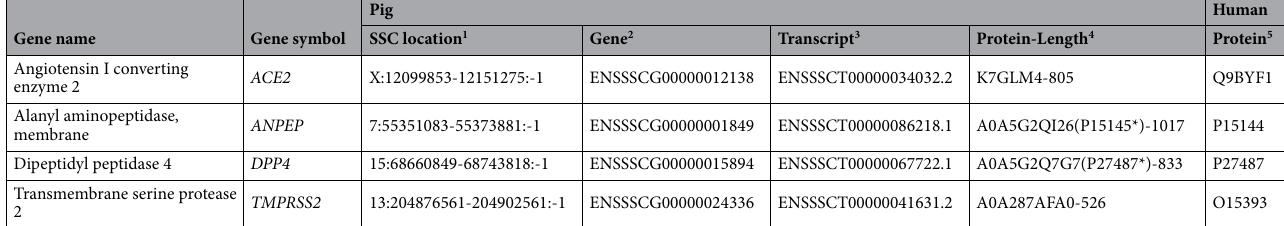
Table 1. Candidate genes investigated in the present study. 1 Porcine chromosome, starting position, ending position, gene orientation. Coordinates are based on the Sscrofa11.1 reference genome; 2 Ensembl gene identifier; 3 Ensembl canonical transcript identifier (it is defined as the longest CCDS translation with no stop codons); 4 UniProtKB accession number related to the Ensembl canonical transcript. The number of residues of the protein is reported; 5 UniProtKB accession number. *Alternative reviewed entry